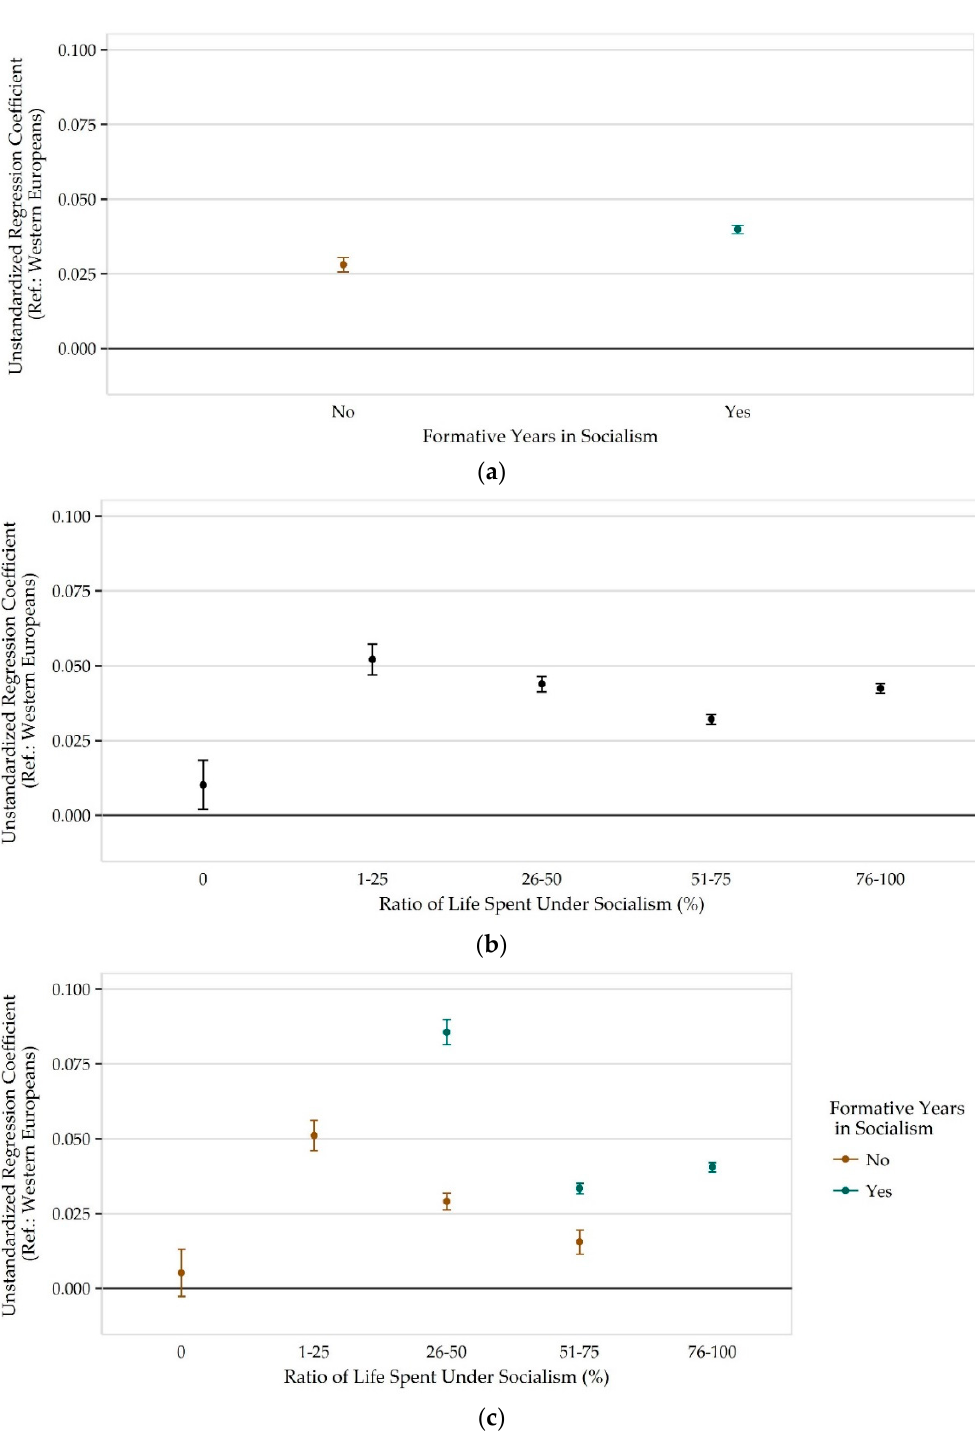
Figure 2. Value of (unstandardized) regression coefficients of “Post-socialist” country dummy for explaining justice evaluation of subjective Gini: ( a ) Respondents divided by their formative year; ( b ) Respondents divided by their exposure rate; ( c ) Respondents divided by their formative years and their exposure rate. Notes : ISSP, own calculations. Marginal effects with 95% confidence interval from bootstrapped OLS regressions. For corresponding models and analysis see Tables A4–A6 in Appendix D.